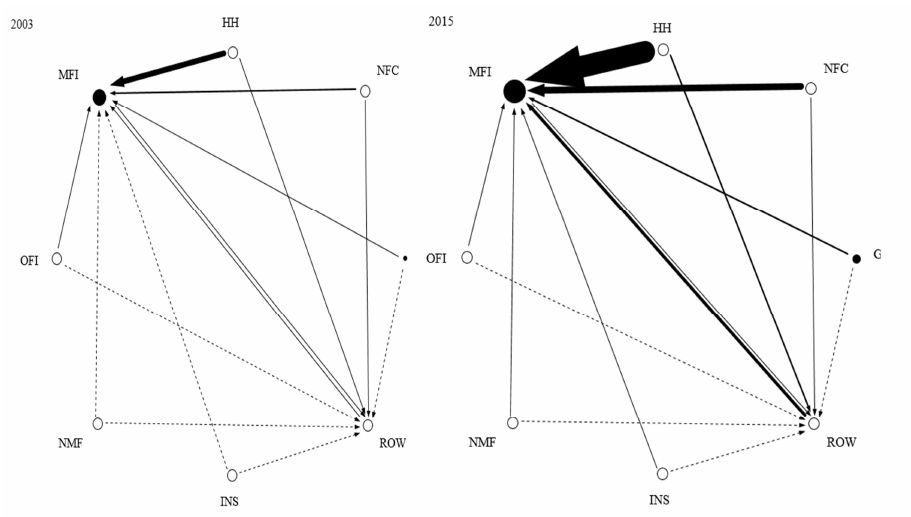
Figure 2. Currency and deposits flows * in 2003 and